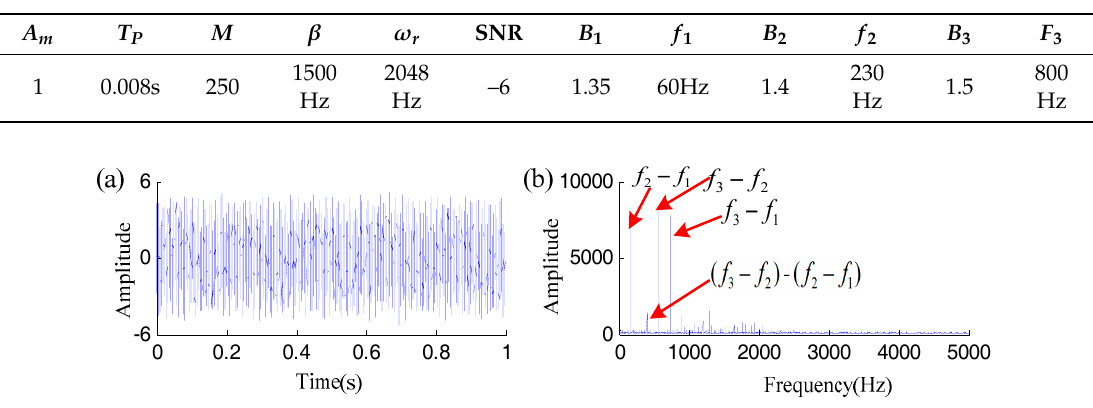
Table 1. Parameters of the simulated signal. Signal-to-noise ratio (SNR).